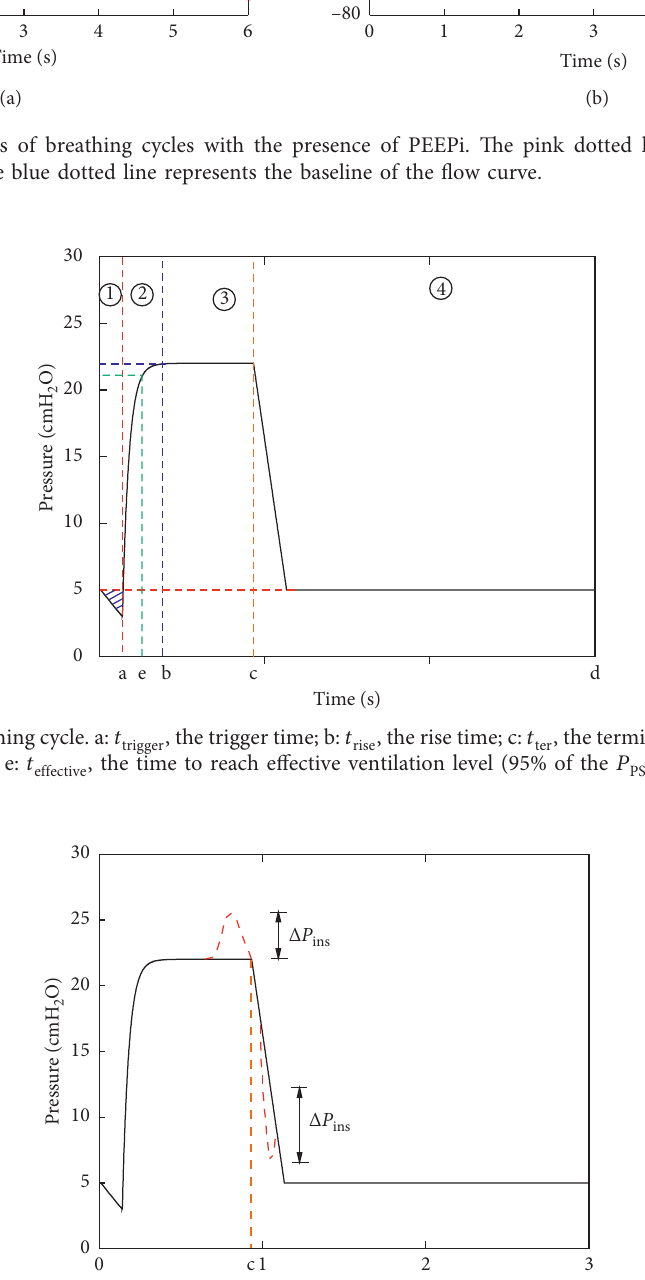
Figure 14: The characteristics of PVA in the amplitude of pressure